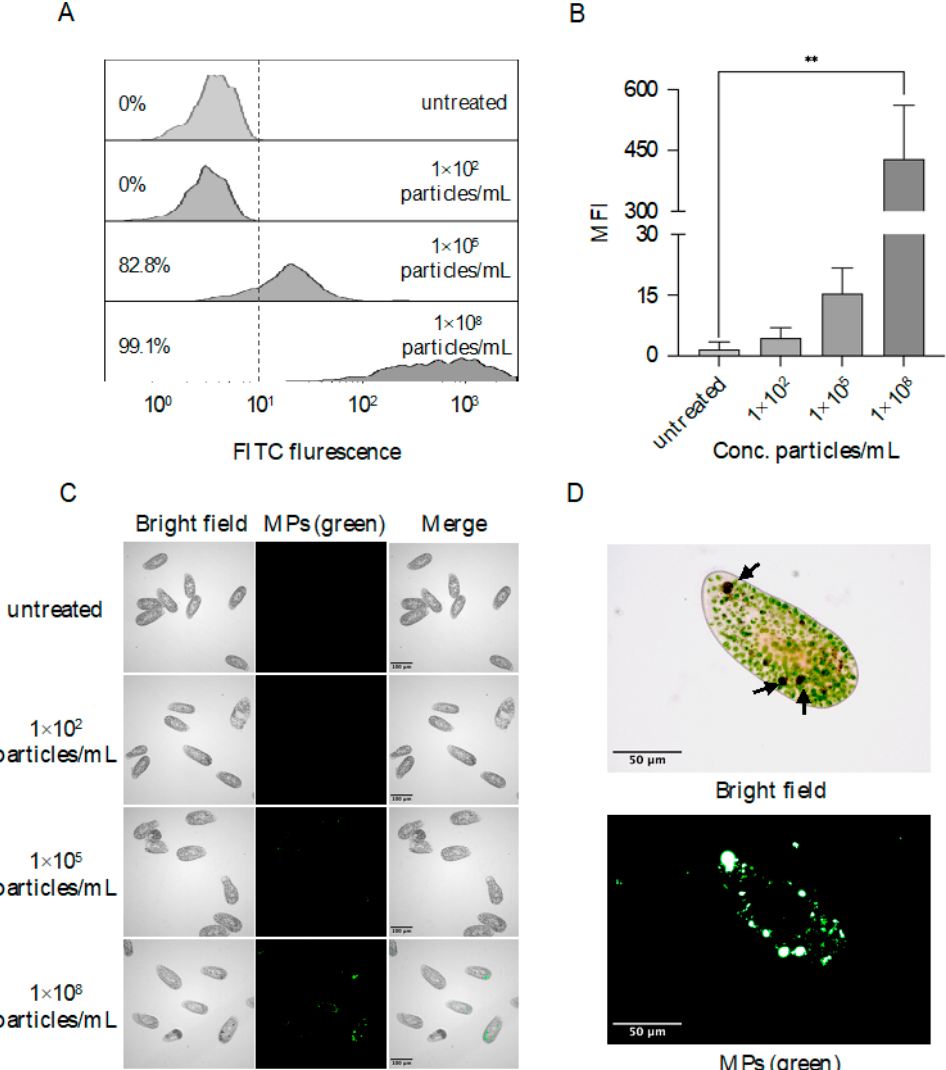
Figure 2. Flow cytometric and fluorescent microscopic analysis of MPs uptake by P. bursaria . Cells at the logarithmic growth phase were exposed to MPs at concentrations of 1 × 10 2 , 1 × 10 5 , and 1 × 10 8 particles/mL, respectively. After 24 h exposure, cells were fixed using 4% buffered Paraformaldehyde (PFA) prior to flow cytometric ( A ) and fluorescent microscopic ( C ) analysis. At least 1000 events were collected for flow cytometric analysis, and the median fluorescent intensity of each group was calculated. The data are represented as the mean ± SD of three independent experiments, and asterisks above the line denote a significant difference (** p < 0.01) between means identified by the line in ( B ). A proportion of cells treated with 1 × 10 8 particles/mL of MPs was also stained with 0.1% Congo red dye for 1 h to locate food vacuoles prior to fixation and fluorescent microscopy imaging as detailed above. Food vacuoles within P. bursaria are indicated by black arrows in ( D